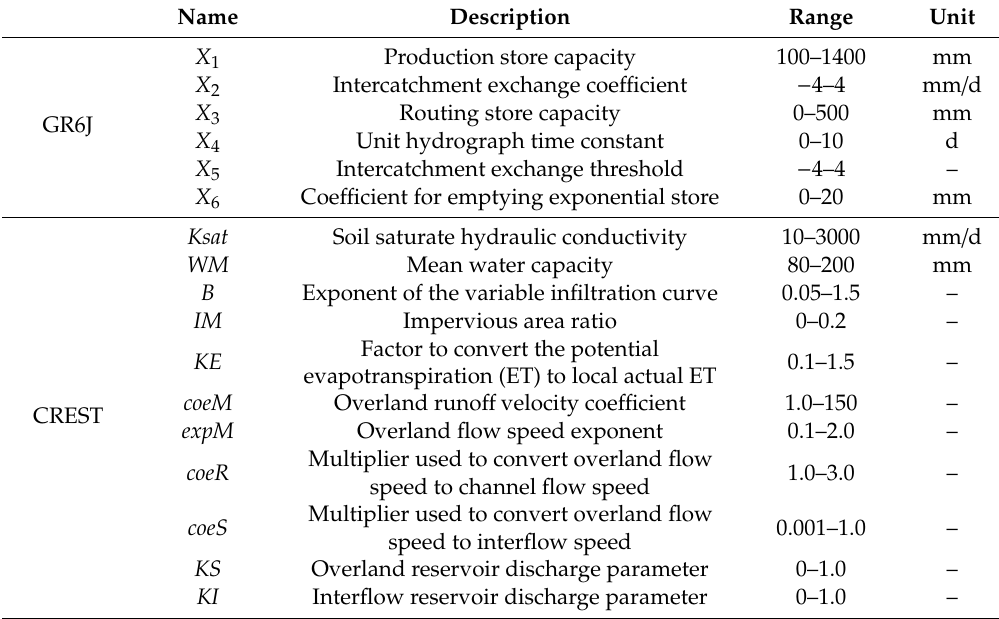
Table 1. Parameter information used in the lumped GR6J and distributed CREST